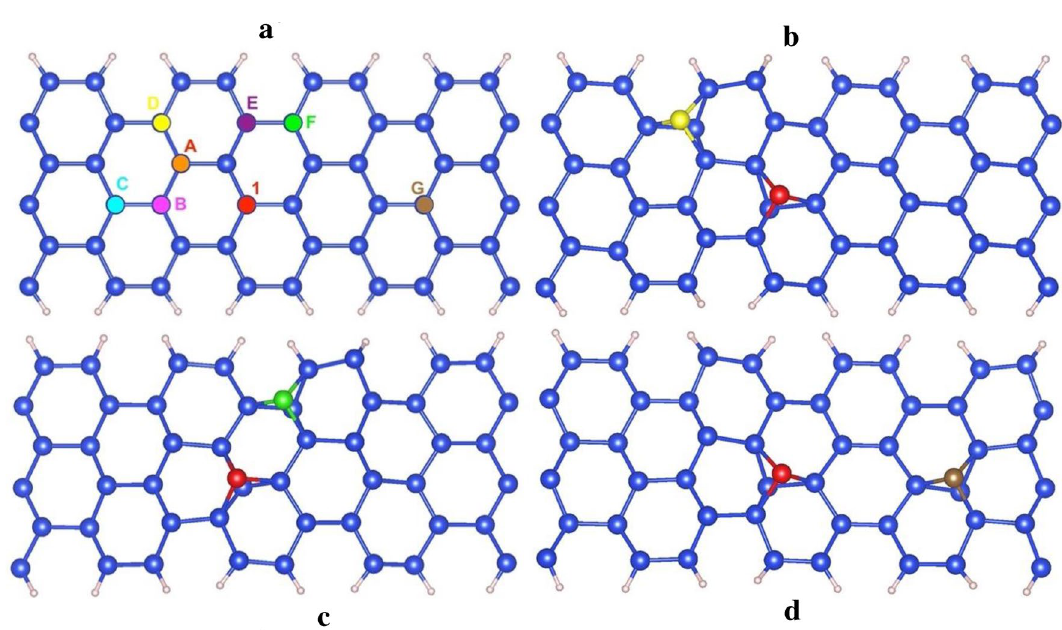
Figure 3. ASiNRs:H from the top view with 1 Si’ atom adsorb at site 1 and another Si’ atm at different positions from A to G ( a ). ASiNRs:H with di-adatom at site 1-D ( b ), site 1-F ( c ), and site 1-G ( d ). The blue and pink balls represent for Si and H in ASiNRs:H, respectively. The red, yellow, green, and brown balls are the adsorbed Si’ atom at site 1, D, F, and G,